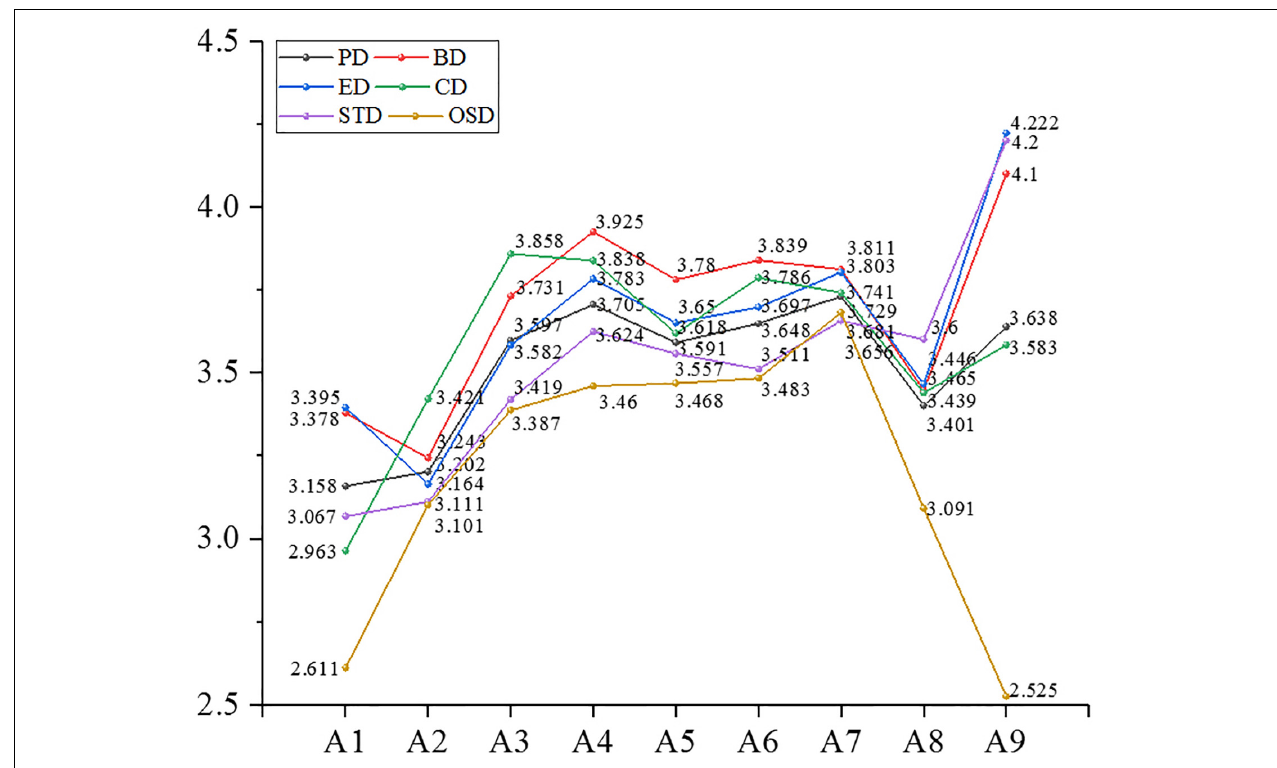
FIGURE 7 | Mean value of psychological distance and dimensions thereof in the age. Note : PD: psychological distance; BD: behavioral distance; ED: emotional distance; CD: cognitive distance; STD: spatial-temporal distance; OSD: objective social distance; ExD: experiential distance (the same below).